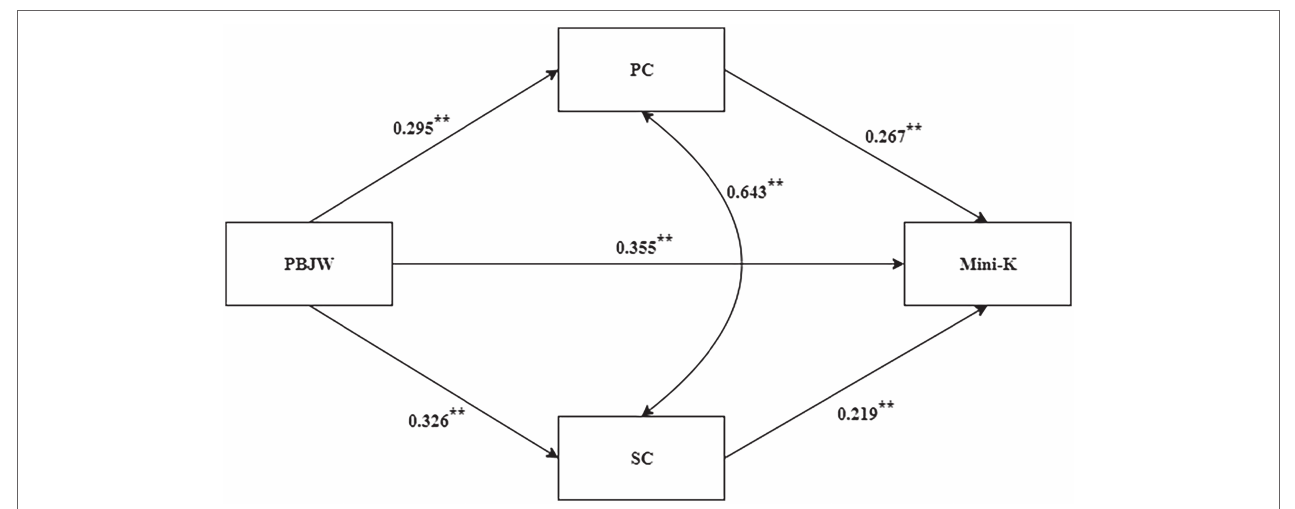
FIGURE 1 | Parallel mediator model. ** p < 0.01.